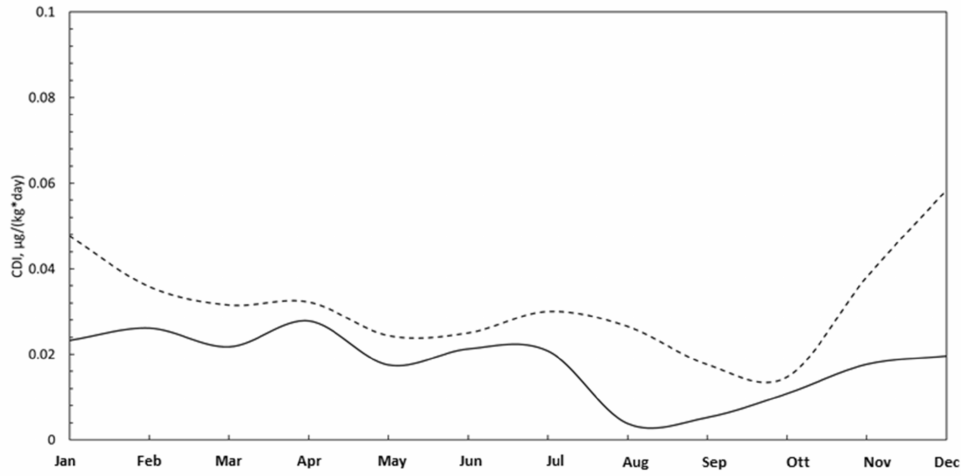
Figure 13. Lead (Pb) CDI for the HI (solid black line) and LI (dashed black line) area for every month in